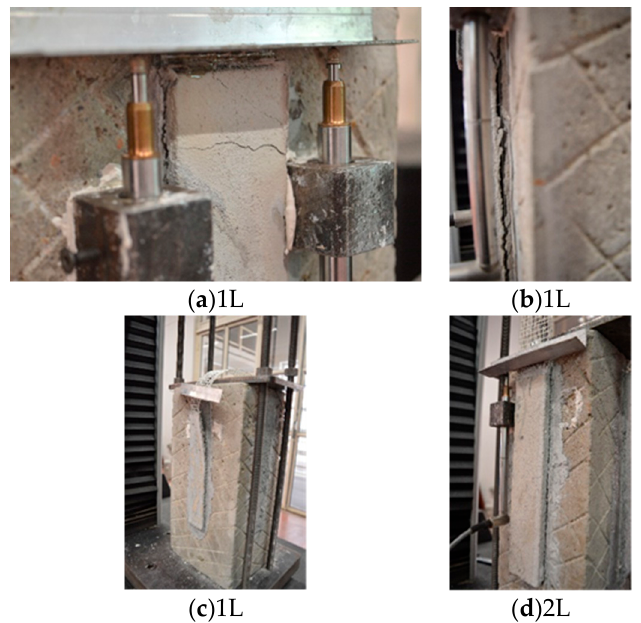
Figure 5. Direct shear test: ( a ) Transversal cracks of specimen with one layer of steel fabric (1L), ( b ) interfacial crack of specimen with one layer of steel fabric; ( c ) failure of specimens with one layer of steel fabric; ( d ) failure of specimens with two layers of steel fabric (2L).